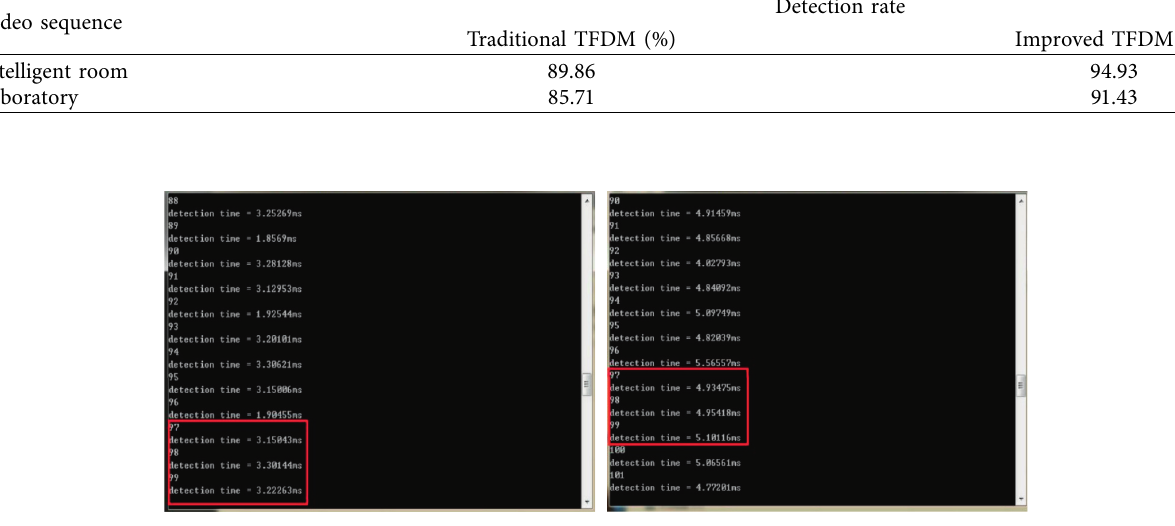
Figure 6: Running time of the frame difference method before and after improvement. Table 2: Comparison of processing time between the traditional TFDM and the improved